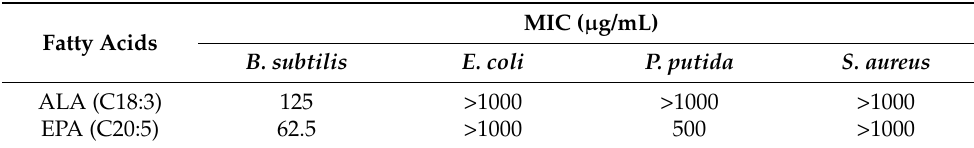
Table 5. Minimum inhibitory concentrations (MICs) of α -linolenic acid (ALA) and eicosapentaenoic acid (EPA) fatty acids against food-contaminating